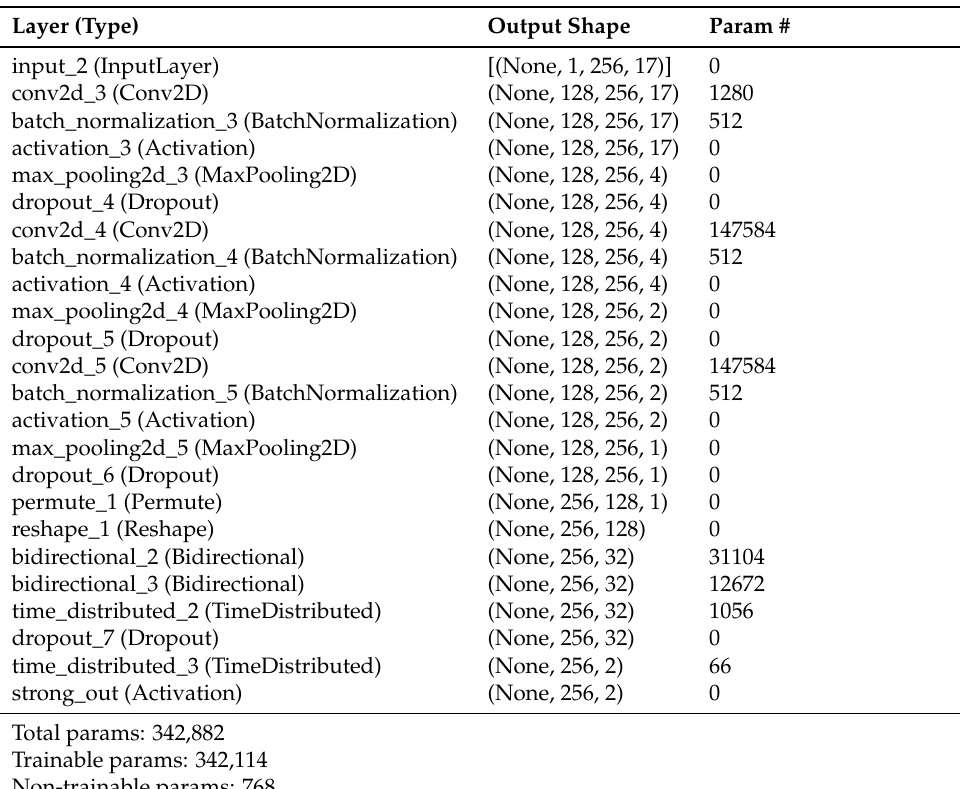
Table 1. SED model